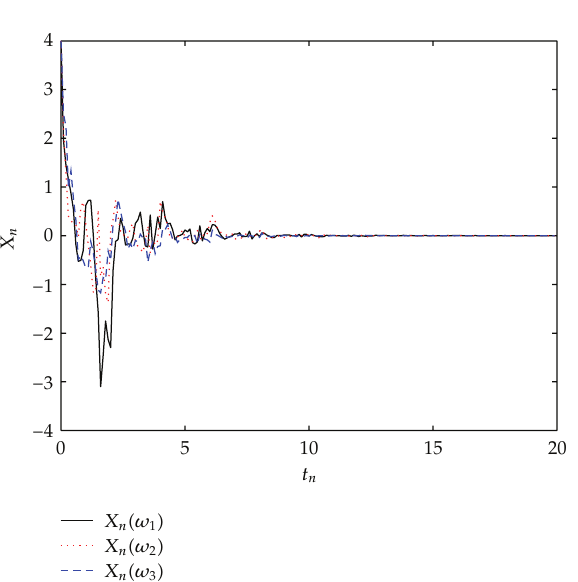
Figure 2: Almost surely asymptotic stability of the BEM approximate solution X n with the stepsize h (cid:7) 0 .